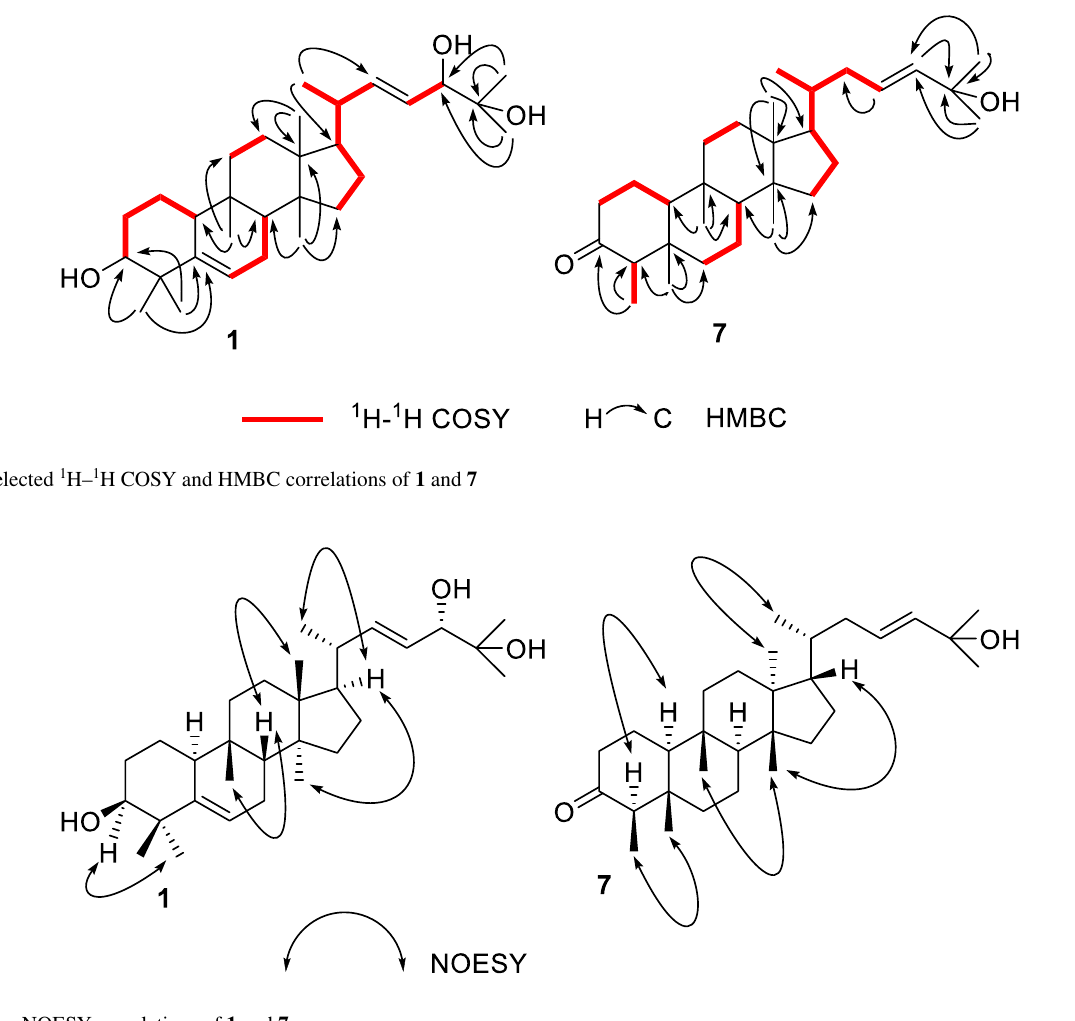
Fig. 3 Key NOESY correlations of 1 and